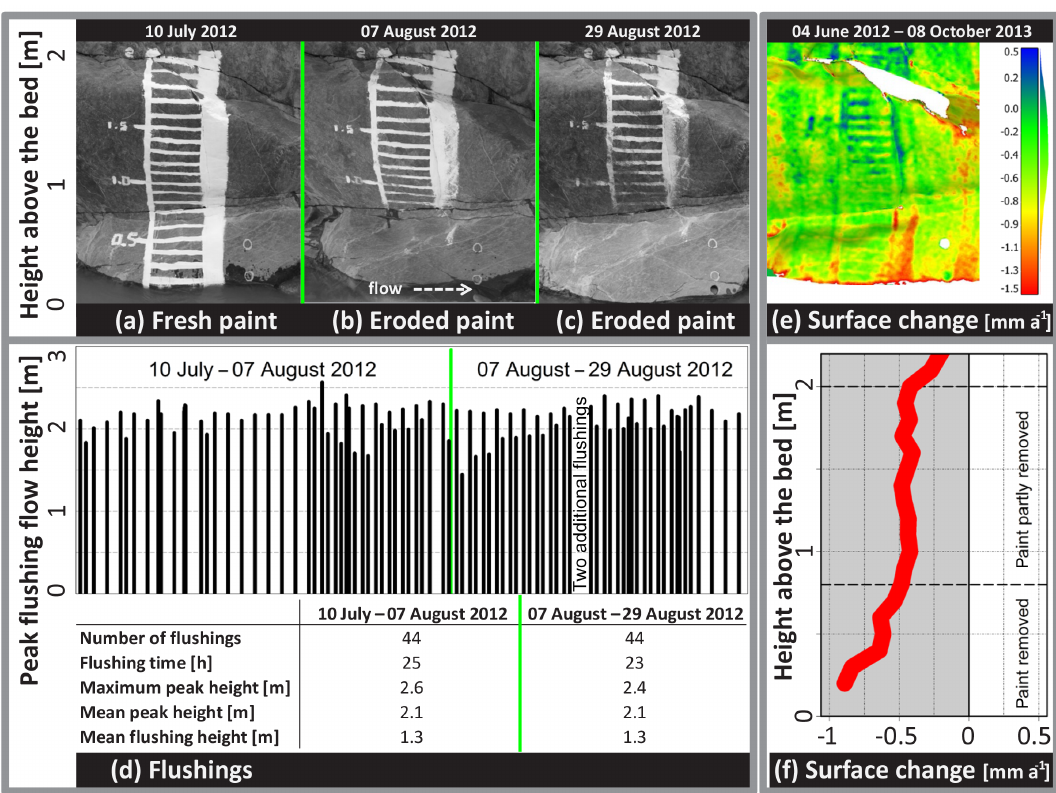
Figure 2. The erosion pattern on the painted staff gauge on the left gorge wall (cf. Fig. 1c and d) indicated a region above the stream bed in which the sediment tools effect leads to accelerated lateral erosion: (a) the freshly painted staff gauge, (b) the eroded staff gauge after a period of 44 flushing events, (c) the eroded staff gauge (not repainted on 7 August 2012) after an additional period of 44 flushing events, (d) time series of the flushing event peak flow heights for both periods, (e) mean at-a-point bedrock change detection values (more than 2million points) from repeated terrestrial laser scanning over the 2 years 2012–2013 (the time span 4 June 2012 to 8 October 2013 includes nearly all flushing events in these years; for data and calculation, see Beer et al., 2016), and (f) variation in bedrock erosion rates with height over the stream bed. For two flushings of the second painting period, no flushing height data exist (see the data gap in d ), but the flushing discharge was comparable to the adjacent flushings. Paint erosion and additional paint coating at different positions in between the scanning dates led to some of the extreme change detection values in (e) that reflect the painted gauge pattern (see the text for details). The vertical erosion profile in (f) is based on the mean values of horizontally binned at-a-point erosion rates given in (f) , with a bin height of 0.1m. This profile is only slightly distorted by the erroneous extreme change values from paint erosion (see e ), due to the huge number of TLS measurements included. The grey background area in (f) symbolizes the region of the bedrock wall, with the change value of 0mma − 1 defining its original surface, and erosion penetrating into it. Note the different y axes of the individual